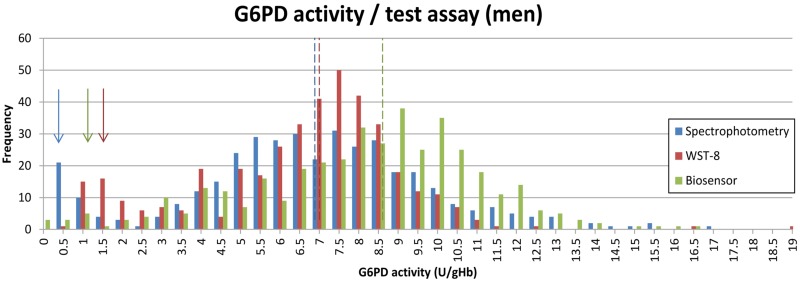
G6PD activity distribution according to different assays among the male study population.Arrows indicate peak for G6PDd samples / assay, dotted lines indicate AMM / assay.